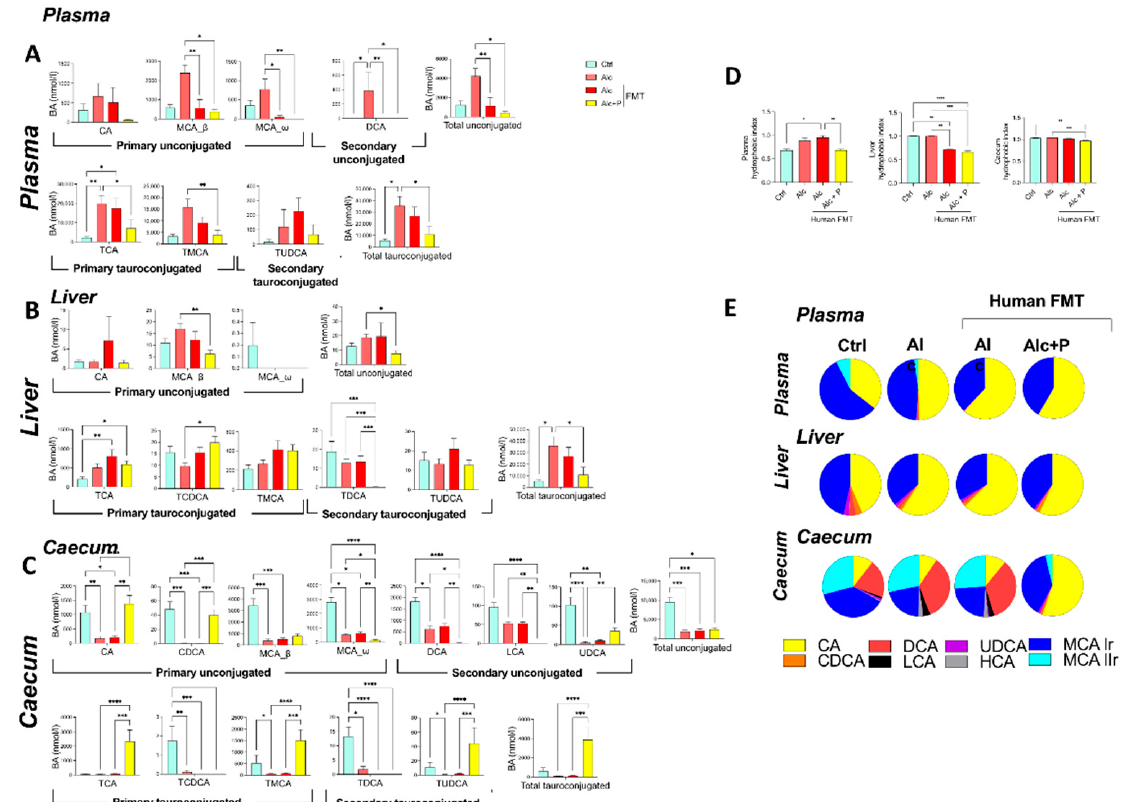
Figure 3. Pectin alters the bile-acid (BA) composition in alcohol-fed mice. Control (Ctrl) and alcohol- fed (Alc) mice received a Lieber DeCarli diet with isocaloric maltodextrin or alcohol, respectively. Pectin-treated mice (Alc + p ) received 6.5% pectin in addition to 5% ethanol. Human fecal microbiota transfer (FMT) groups received fecal microbial transplantations from a patient with alcoholic hepa- titis. BA composition in the plasma ( A ), liver ( B ), and caecum ( C ), hydrophobic index ( D ), and the relative composition of the bile pool ( E ). * p < 0.05, ** p < 0.01, *** p < 0.001, **** p < 0.0001.